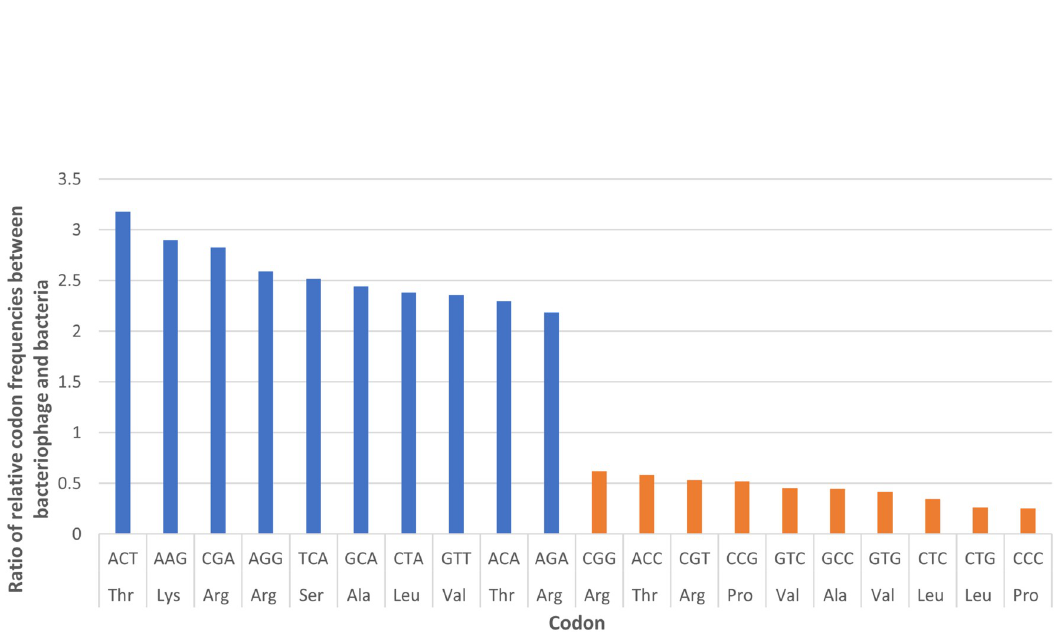
Fig 7. Proteomic tree showing the genome-wide proteomic diversity of KMI8 and related bacteriophages. Black box indicates KMI8.